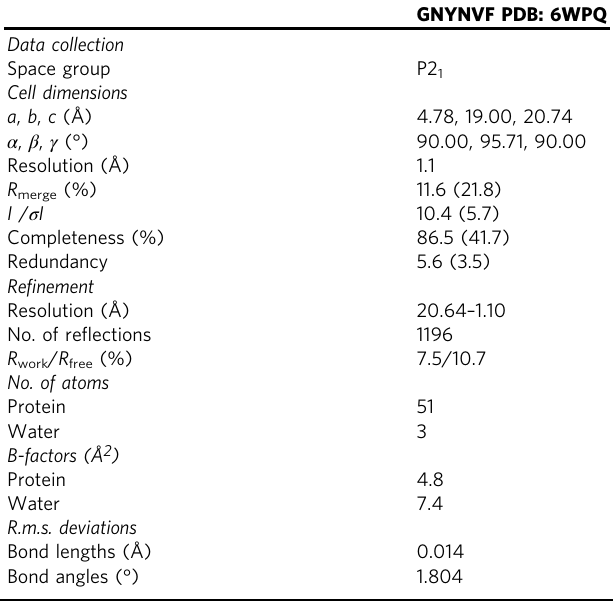
Table 3 Statistics of X-ray crystallography data collection and re fi nement.